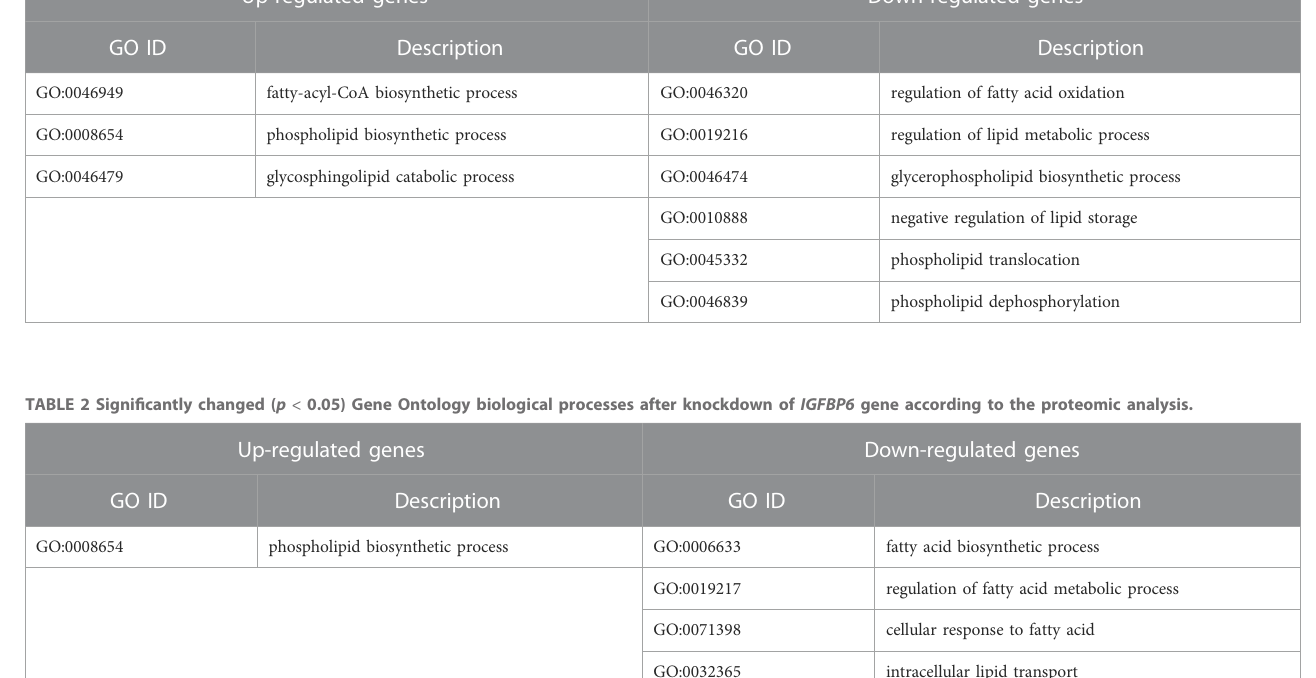
TABLE 1 Signi fi cantly changed ( p < 0.05) Gene Ontology biological processes after knockdown of IGFBP6 gene according to the transcriptomic analysis. Up-regulated genes